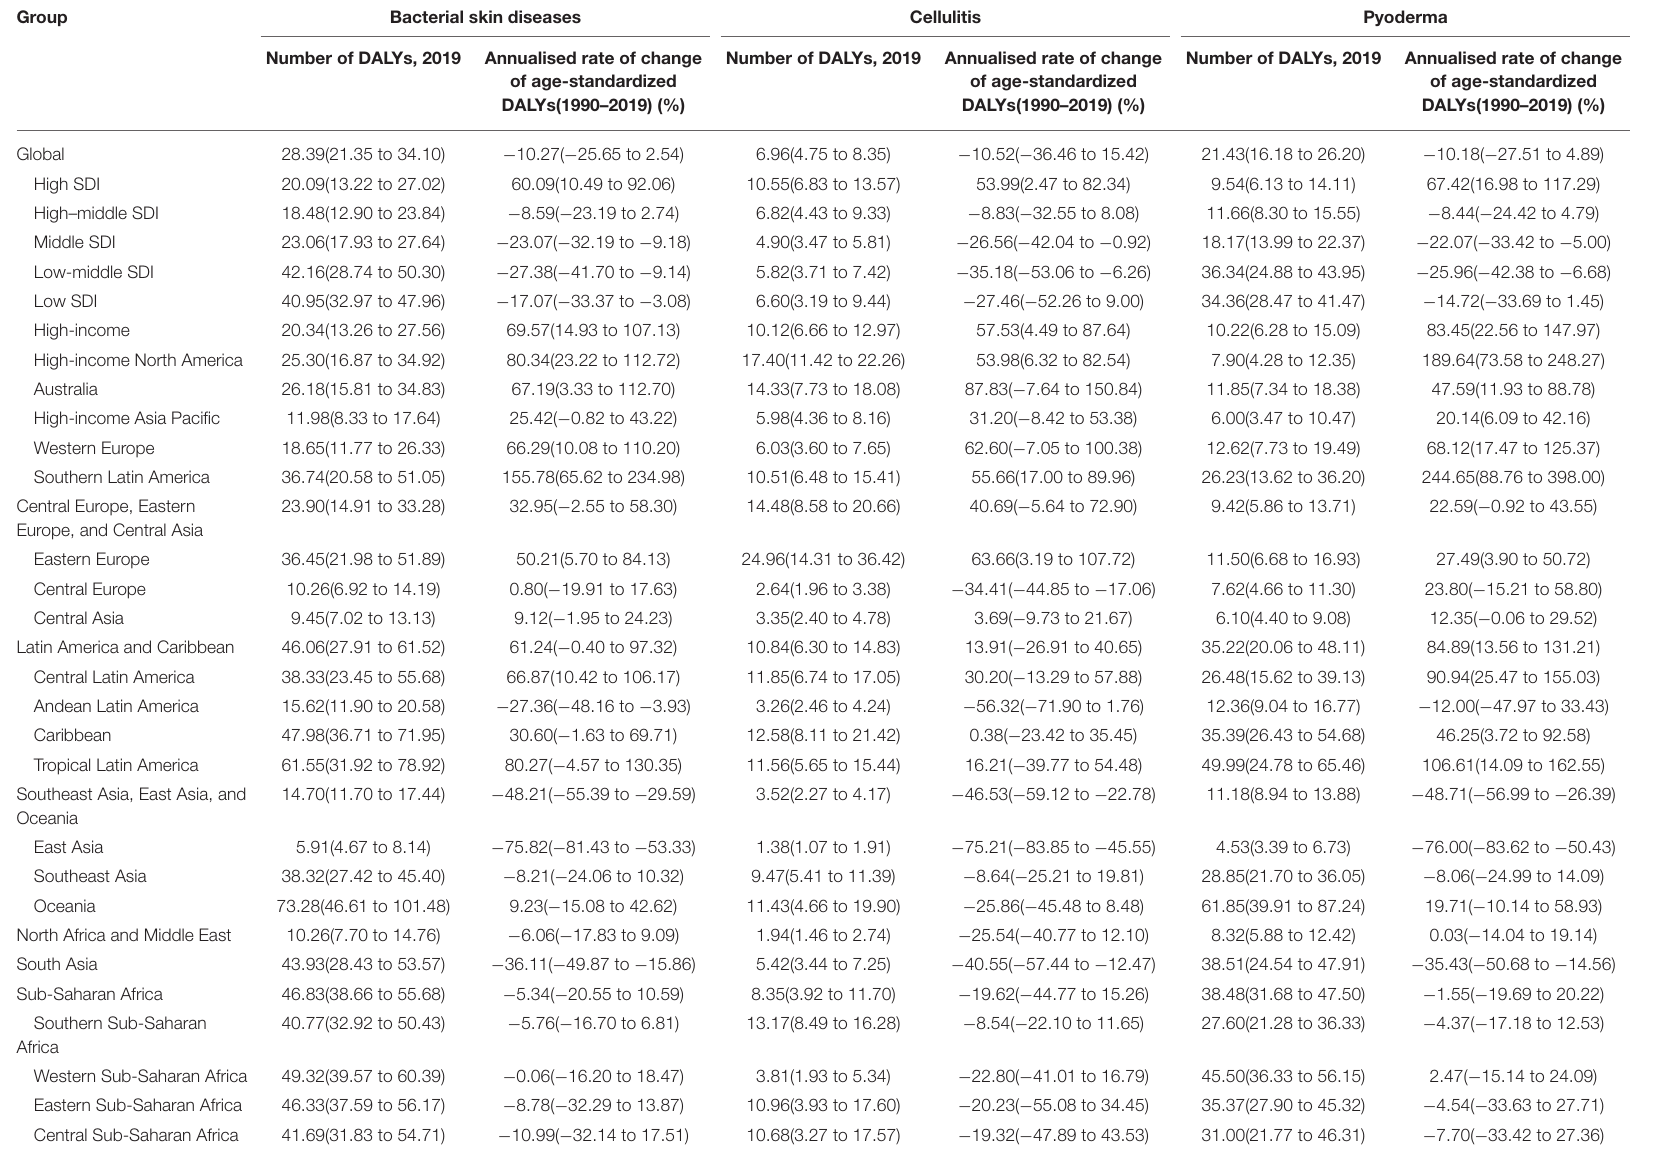
TABLE 2 | Age–standardized DALYs rate of major bacterial skin diseases in 2019, and change of age–standardized DALYs rate for both sexes (1990–2010 and 2010–2019). Group Bacterial skin diseases Cellulitis Pyoderma Number of DALYs, 2019 Annualised rate of change Number of DALYs, 2019 Annualised rate of change Number of DALYs, 2019 Annualised rate of change of age-standardized of age-standardized of age-standardized DALYs(1990–2019) DALYs(1990–2019) (%) DALYs(1990–2019) (%)